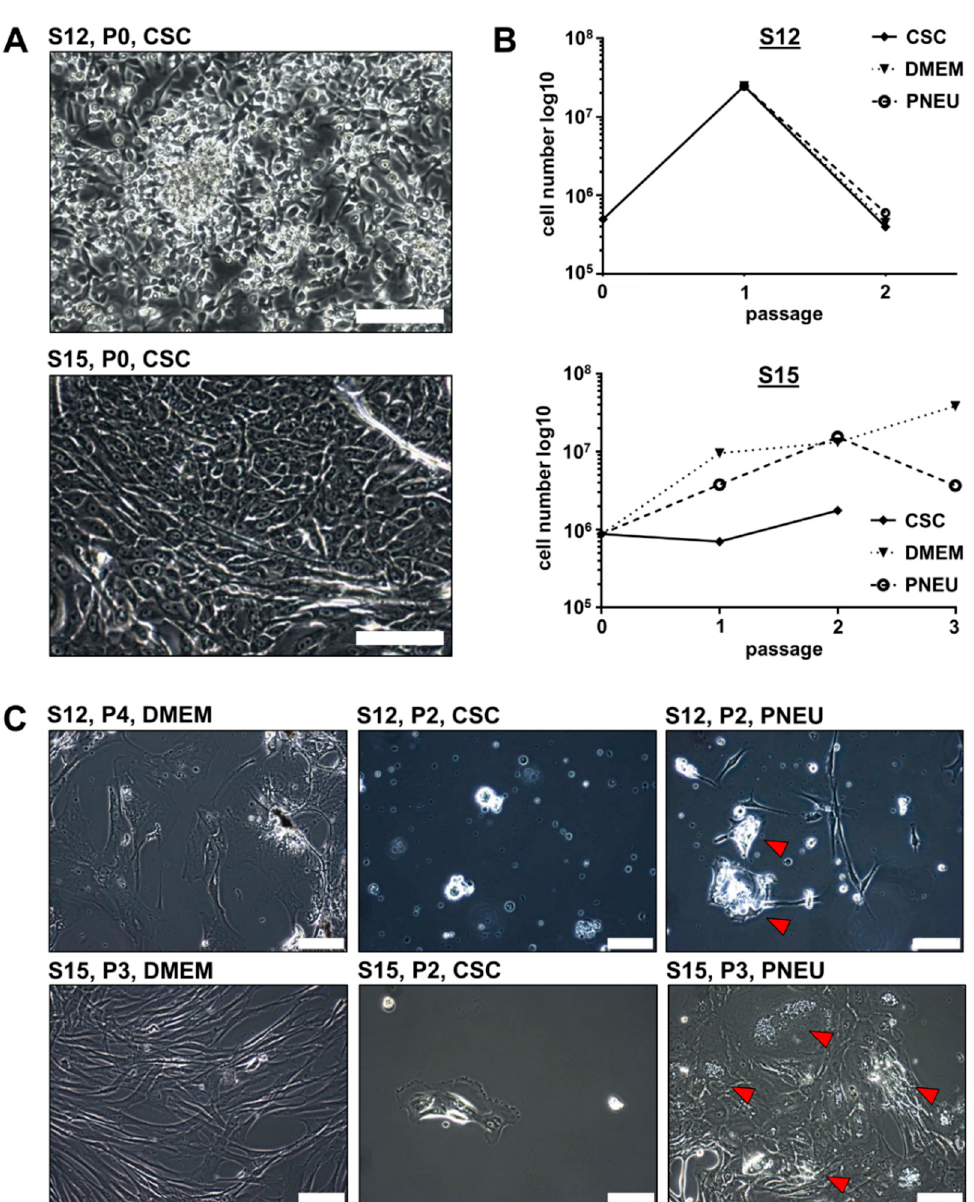
Figure 2. HNSCC cell culture establishment in serum-free CSC-medium. ( A ) Fresh primary cells of S12 and S15 display large epithelial cell compartment. ( B ) Growth curves show cell proliferation of S12 cells until passage 1 in CSC-medium followed by a decline in cell numbers after splitting into three different media. S15 cells expanded in DMEM and PNEU-medium, but showed poor proliferation in CSC-medium. ( C ) Upon initial passaging, cells were split into DMEM, CSC, and PNEU-medium, which resulted in fibroblast-like cell expansion in DMEM; no or neglectable expansion of epithelial cells in CSC-medium; epithelial cells expanded in PNEU-medium until passage 2 of S12 and S15. Then, PNEU cultures displayed growth of fibroblast-like cell types, while epithelial cells frequently acquired a phenotype reminiscent of cornification (arrows); scale bars = 100 µ